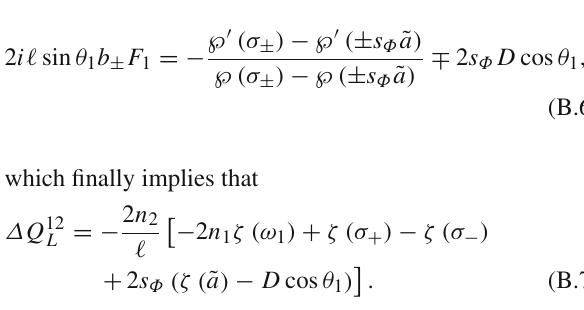
Table 3 The dependence of the signs of ˜ a , D 2 and the sign s Φ on the angle θ 1 θ 1 s Φ sgn Unstable trans. invariant